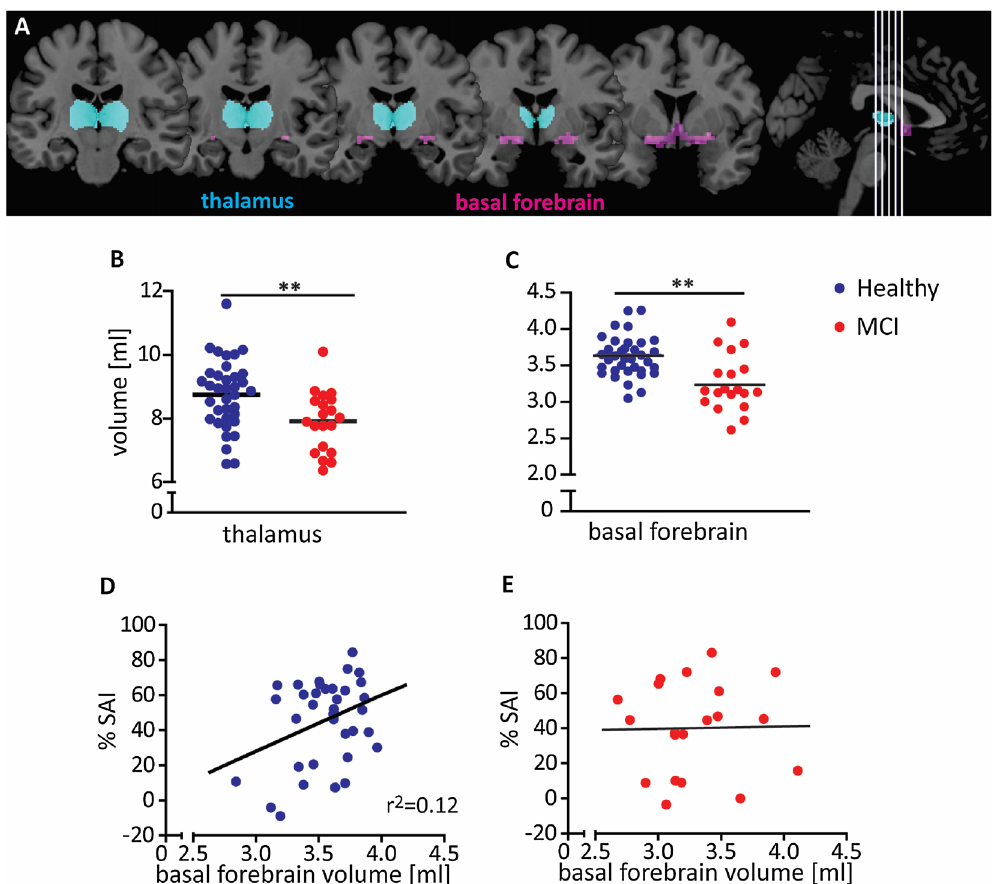
Figure 1. ( A ) Anatomic representation of the basal forebrain cholinergic system (pink) and the thalamus (turquoise) regions of interest. Thalamus ( B ) and basal forebrain volumes ( C ) were smaller in patients with mild cognitive impairment (n = 20; red) than in healthy volunteers (n = 36; blue). In healthy volunteers, a larger basal forebrain was associated with stronger short-latency sensory afferent inhibition (SAI) ( D ) while there was no association in MCI patients ( E ). All volume data were corrected for total intracranial volume. **p <